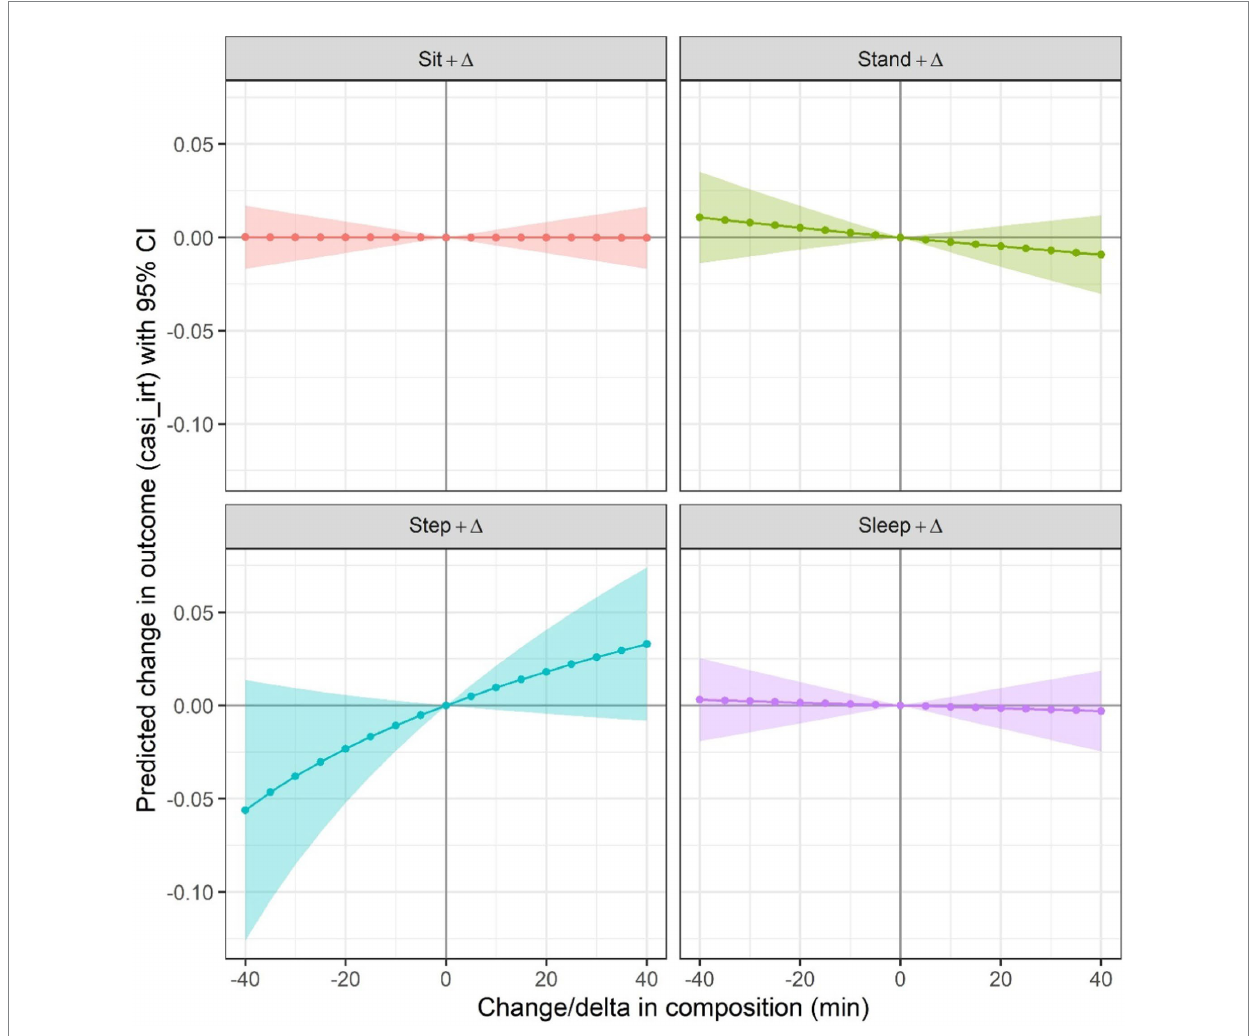
FIGURE 2 Predicted difference in outcome from CoDA when increasing one of sleep, sit, stand step, while proportionally decreasing each of the other 3 behaviors. N = 1000 (34 observations were not included due to missing values on covariates). Each one of the four subgraphs presents a curve of the predicted difference in mean outcome associated with increasing/decreasing time/day on the behavior (indicated in the header of the subgraph) by ∆ mins, while accounting for that difference by proportionally decreasing/increasing time/day spent on other behaviors by a common factor. The curve presented in each graph is estimated based on the fitted model with CASI-IRT score as the outcome, and with ilr -coordinates as predictors in which the behavior (indicated in the header of the subgraph) as the numerator behavior in the pivot coordinate, adjusted for age groups (65–74, 75– 84, 85+), sex, non-Hispanic White (Yes, No), body mass index, depressive symptoms score, and self-rated health condition. The shaded area in each subgraph corresponds to pointwise 95% confidence intervals, where overlap with the horizontal line at 0 indicates a null association. The baseline composition for each of these analyses equals to the compositional mean in the sample, i.e., 10.2 h (42.6%) sit, 3.7 h (15.3%) stand, 1.2 h (5.2%) step and 8.8 h (36.9%)